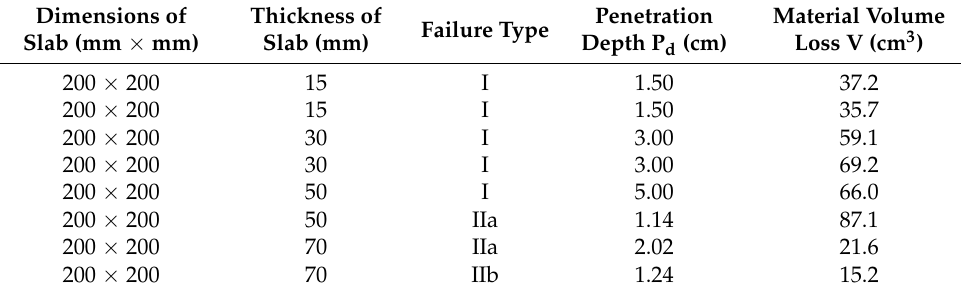
Table 4. Projectile impact results for mixture